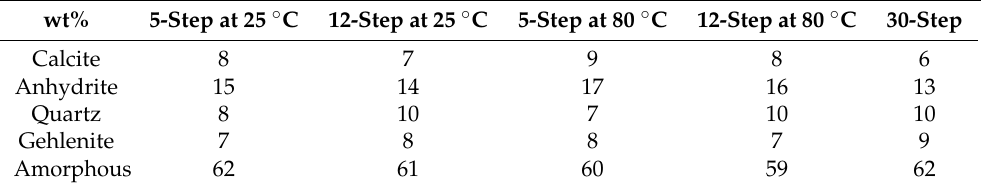
Table 6. Mineralogical composition (wt%) of fly ash after FH-WW. Crystalline phase content is estimated with an error of 1% wt, while amorphous fraction content is estimated with an error of 5% wt.